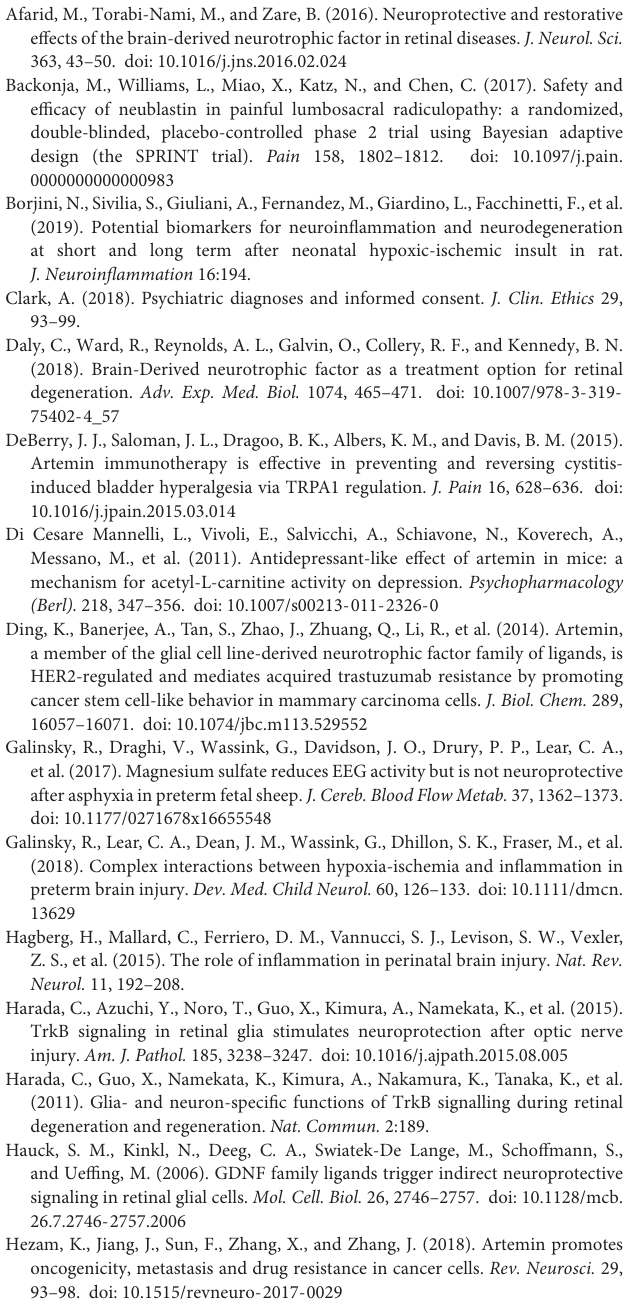
quite strong and extensive throughout all retinal layers in the H 2 O-treated group as compared to in the ARTN-treated group at P29; (C) active ED1 + cells (red) localized in the IPL and INL after HI at P10 and P17. Scale bars: 100 µ m. Supplementary Figure 5 | Post-treatment with ARTN enhances RET phosphorylation in the immature retina after HI injury. Nuclear counterstaining with DAPI (blue) showed (A) the ARTN immunostaining (red) was prominent in the RGC and INL of the ARTN-treated HI group at P10; (B) the immunostaining of phosphorylated RET (pRET, green) localized in the RGC, IPL, and OPL at P10. Scale bars: 100 µ